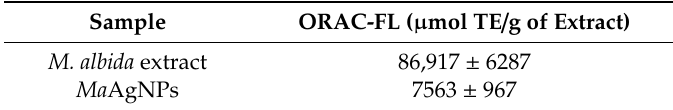
Table 3. Antioxidant capacity of the extract of M. albida and Ma AgNPs.